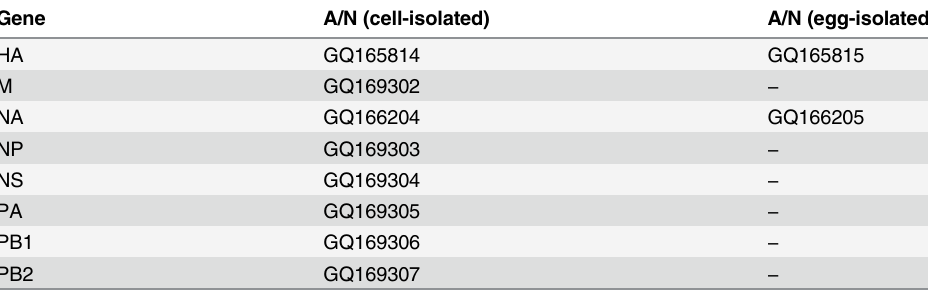
Table 1. GenBank accession numbers of